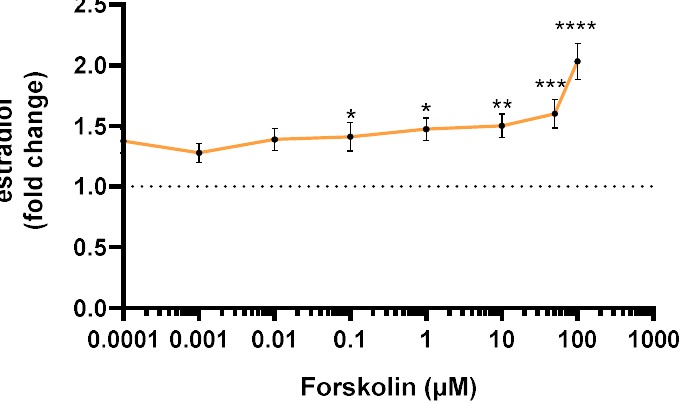
Figure 3. Estradiol secretion by JEG-Tox cells after a 72-h incubation time with forskolin. The dotted line represents the estradiol basal level. The significance thresholds were * p < 0.05, ** p < 0.01, *** p < 0.001 and **** p < 0.0001 compared to the culture medium.